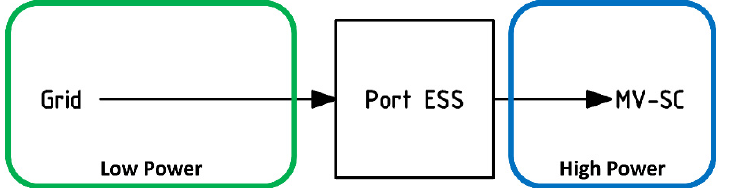
Figure 8. Integration among ESS, renewable sources, grid and MV-SC; second approach.